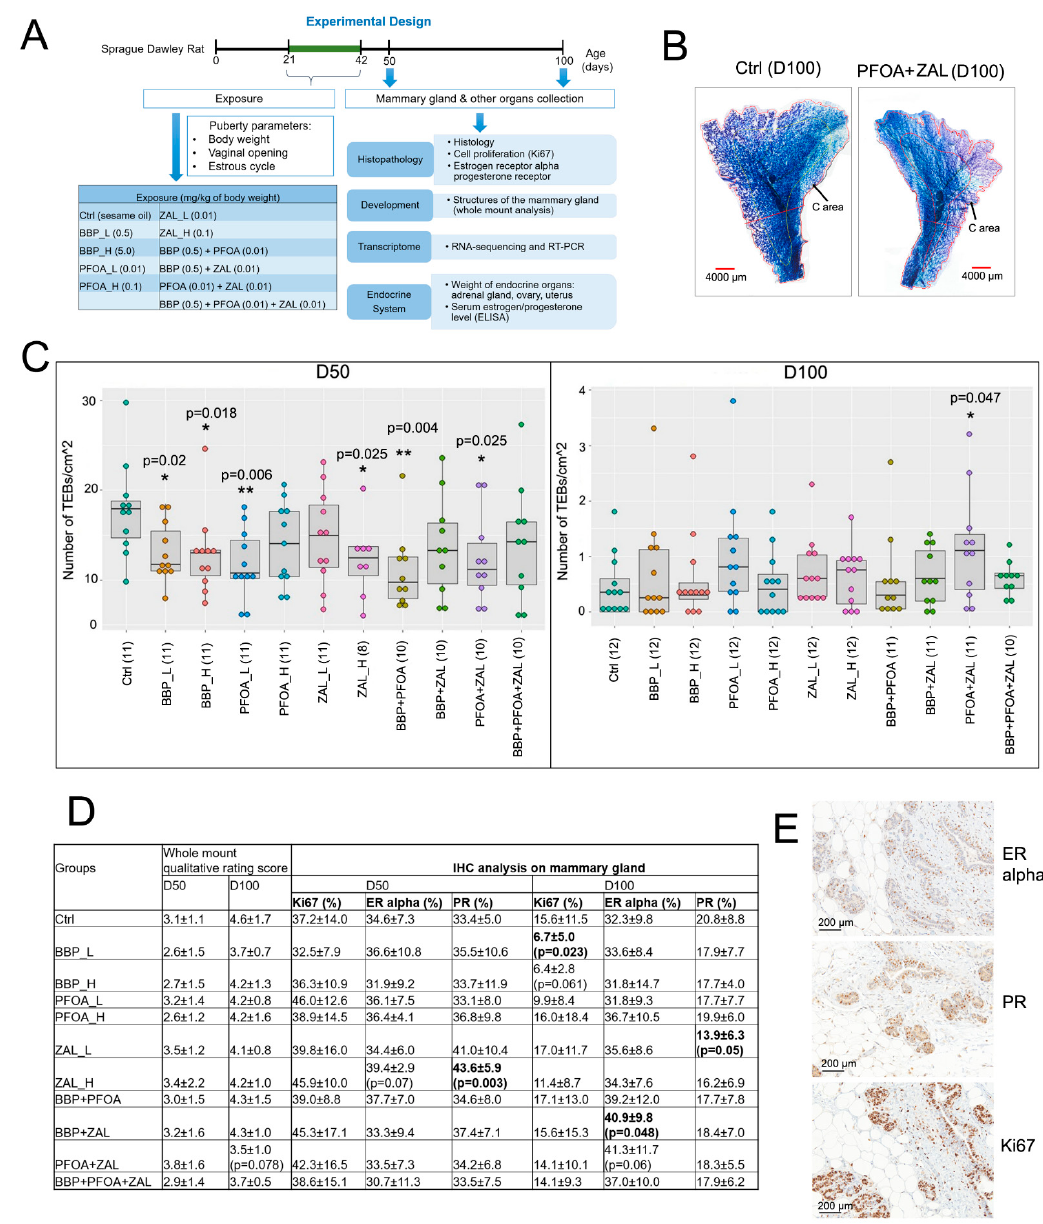
Figure 1. Changes in rat mammary gland development induced by pubertal exposure to BBP, PFOA, and ZAL: ( A ) Experimental design for the study of rat mammary gland development. The rats were treated with 333 µ L of working solution per 100 g of BW through oral gavage. ( B ) Representative images of rat mammary glands #4 and 5 whole mounts at an age of 100 days. Scale bar: 2000 µ m. ( C ) Boxplots show the number of terminal end buds (TEBs) per cm 2 in the C area. TEB is a structure with a bulbous tip 80–120 µ m in diameter on the perimeter of the gland. Each dot in the graph represents one rat. The samples with poor whole-mount preparation were excluded. Sample size is indicated by the numbers within parentheses after the name of each group; this rule is also applied to other figures. ( D ) Table shows the evaluation of mammary gland development by whole-mount qualitative rating, and IHC analyses of Ki67, ER alpha, and PR in the mammary glands. Data are presented as the mean ± STD. ( E ) Representative IHC images of the rat mammary glands. Magnification: 20 × objective. Scale bar: 200 µ m. One-way ANOVA or Kruskal–Wallis one-way analysis of variance on ranks were used to compare the phenotypic changes among 11 groups. Two-sample t -tests or Mann–Whitney rank sum tests were used to compare treated groups with Ctrl. These tests were also applied to Figure 2; * indicates p < 0.05, ** indicates p < 0.01 compared to